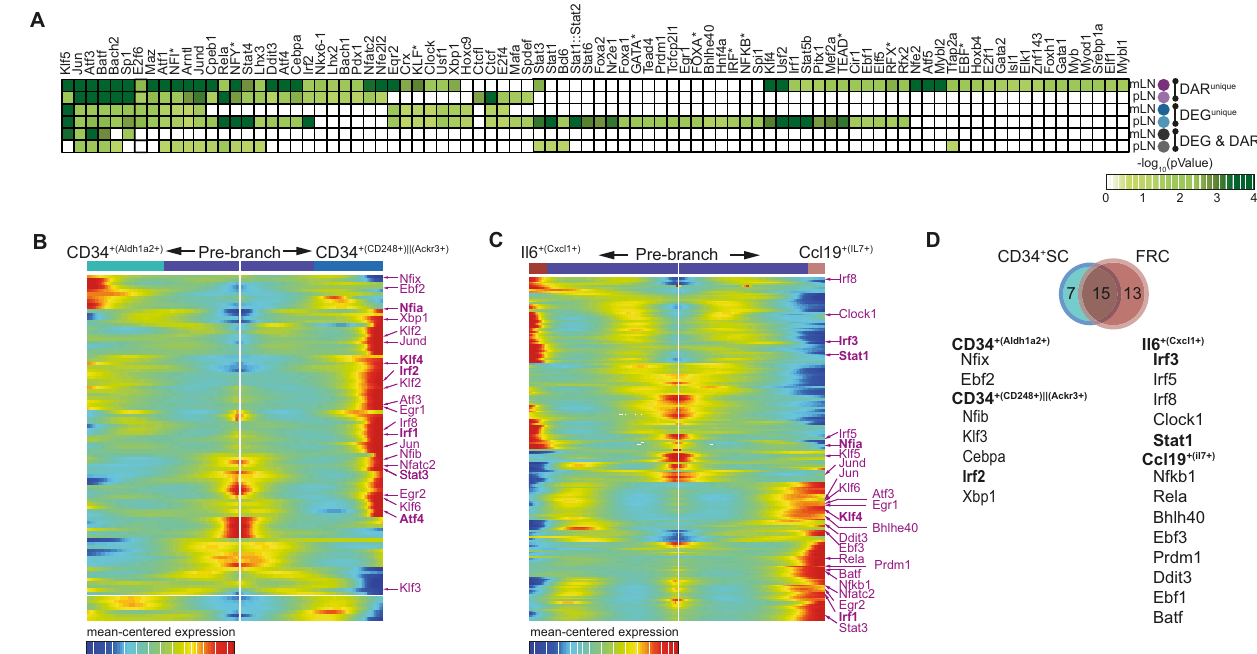
Fig. 5 | TFBS accessibility aligns with dynamically regulated TFs to shape dif- ferentiation and function of key SC subsets within mLNs. A CD45 - CD24 - CD31 - Pdpn + non-endothelialSCswereisolatedfrommLNsandpLNsof7 – 12-week-oldSPF mice. Subsequently, RNA-seq or ATAC-seq analyses were performed (see Fig. 4 for details).The enrichment of known TFBSmotifsfor eachofthe quadrants in Fig. 4F was utilized to identify TFBS over-represented in the accessible chromatin. The heatmap represents the p -value for enriched TFBS and its corresponding putative TF(s). Putatively binding TF families are indicated with an asterix. B , C CD45 - CD24 - cells were isolated from mLNs of day 0, 10, 24, 56, and 300 old SPF-housed mice andsubjectedtoscRNA-seq.Non-endothelialSCswereidenti fi edasnon-LECs,non-